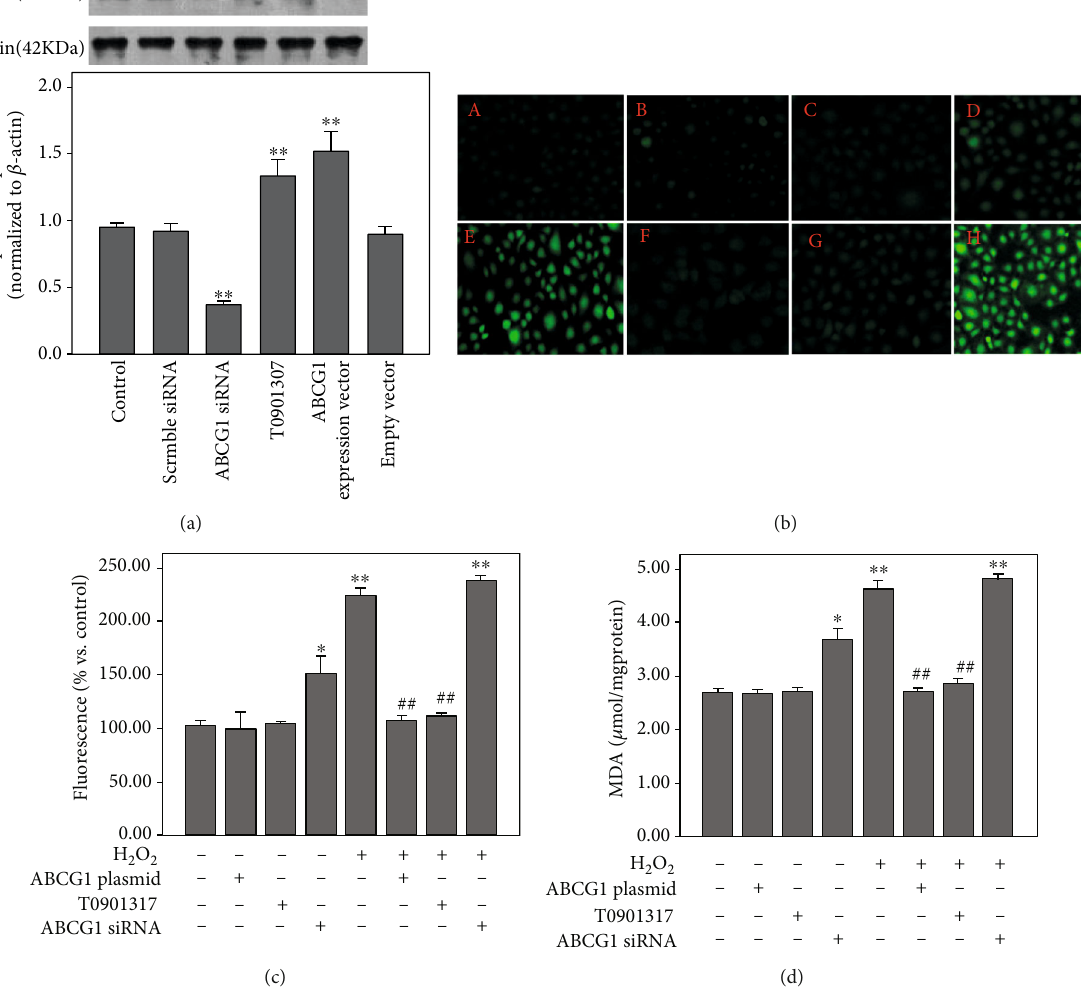
Figure 1: E ff ect of ABCG1 on H O -induced oxidative stress in HUAECs. HUAECs were transfected with the speci fi c ABCG1 siRNA or 2 2 ABCG1 overexpression plasmid or preincubated with the liver X receptor (LXR) agonist T0901317 and incubated with 200 μ M H 12h or not. ABCG1 protein levels were determined using(a) western blot assays. The generation of oxidative stress was assessed by the production of (b, c) ROS and (d) MDA. In (b), intracellular ROS production was measured using CDCFHDA-AM fl uorescence in di ff erent conditions. (A) HUAECs were cultured in medium as normal controls, (B) HUAECs were transfected with the ABCG1 overexpression plasmid, (C) HUAECs were treated with T0901307, (D) HUAECs were transfected with ABCG1 siRNA, (E) HUAECs were exposed for 12 h to 200 μ M H O , (F) HUAECs were transfected with the ABCG1 overexpression plasmid and then cultured with 2 2 O , (G) HUAECs were pretreated with T0901307 and then cultured with H H 2 2 siRNA and then cultured with H O . Representative images are shown for three independent experiments (magni fi cation × 100). Data 2 2 shown are means ± SD ( n = 3 ). ∗ P < 0 : 05 , ∗∗ P < 0 : 001 vs. normal controls; ## P < 0 : 001 vs. HUAECs treated with H